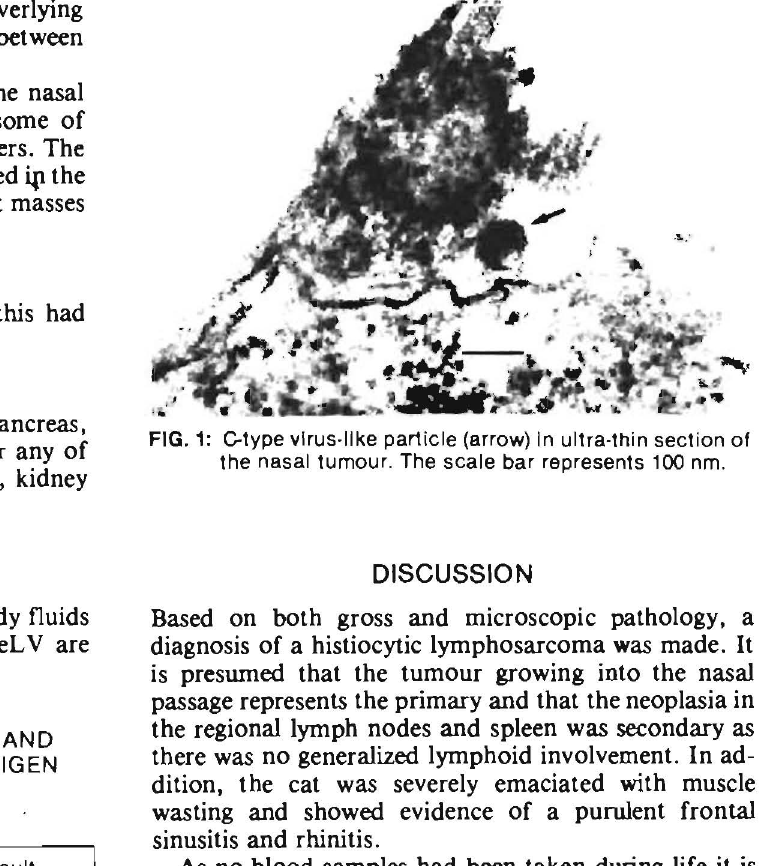
Table 1: EXAMINATION OF BODY FLUIDS AND CRUDE TISSUE EXTRACTS FOR FeLV ANTIGEN